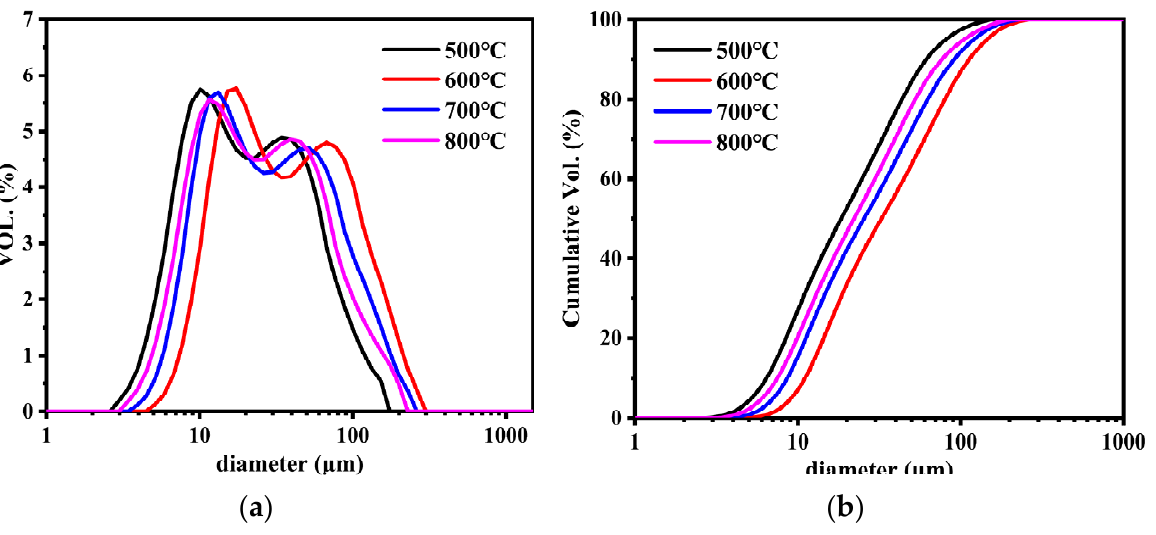
Figure 9. The particle size distribution ( a ) and cumulative size distribution ( b ) of SS@CNTs synthe- sized at various temperatures. Table 5. BET surface areas and porosity characters of SS@CNTs synthesized at various temperatures. Samples